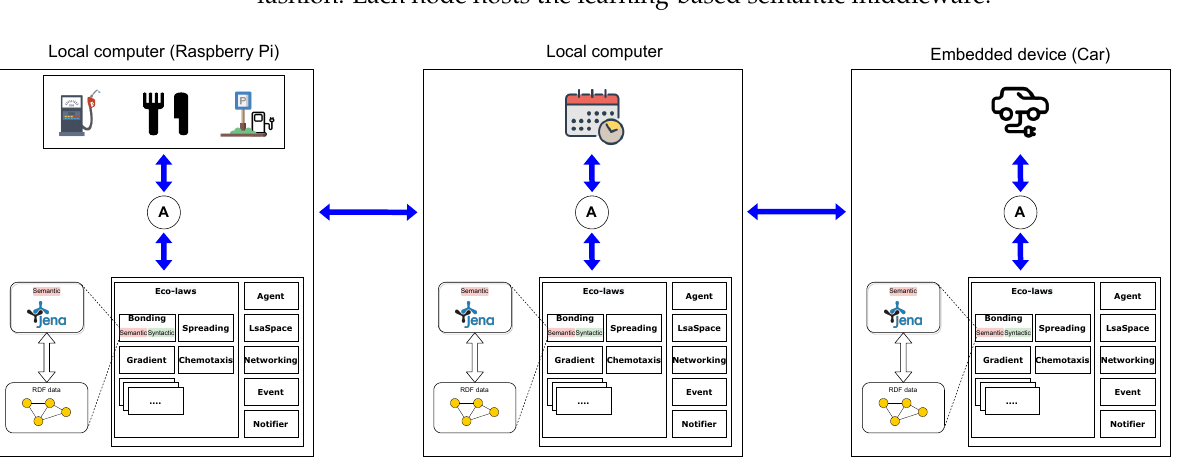
Figure 9. Deployment in a P2P network.